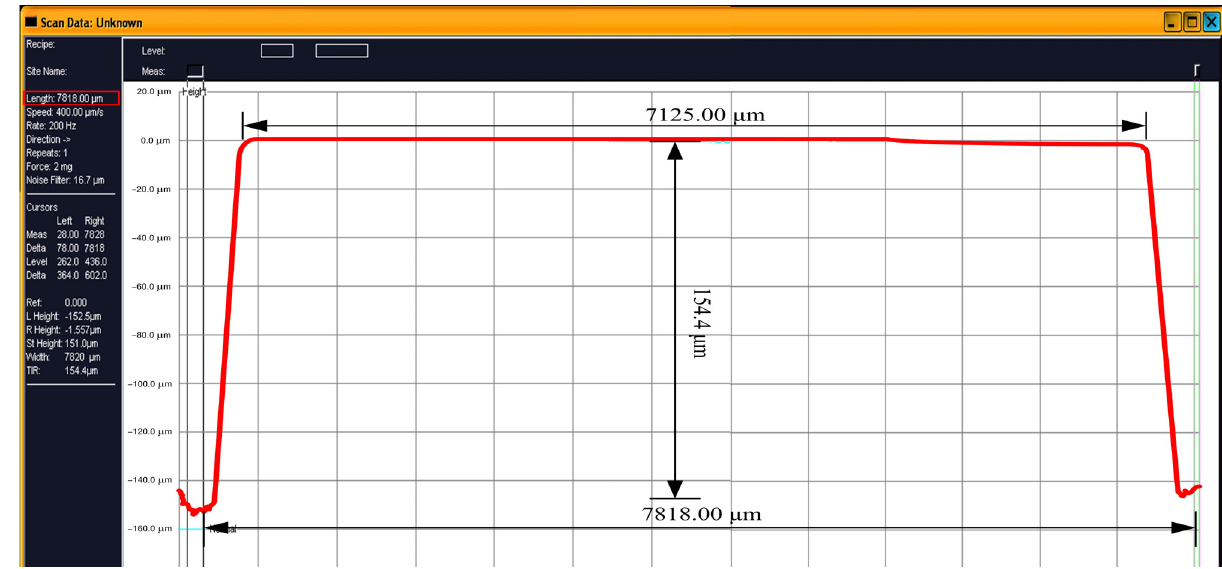
Figure 8. Sensitive membrane sample with 4J33 iron-nickel-cobalt